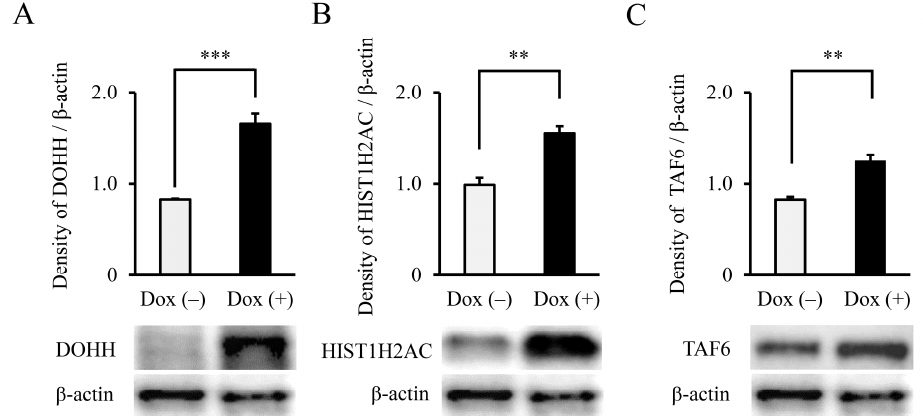
Figure 4. DOHH, HIST1H2AC, and TAF6 proteins induced by NRAS signaling. DOHH (A), HIST1H2AC (B), and TAF6 (C) protein expression in THP-1 B11 cells cultured in the absence and presence of Dox were analyzed by WB. Representative blot images are shown in the lower panels. Densitometry values for each protein standardized by β -actin are shown in the upper panels ( n = 3). Data are expressed as mean ± SD. Statistical significance was determined using an unpaired t -test.